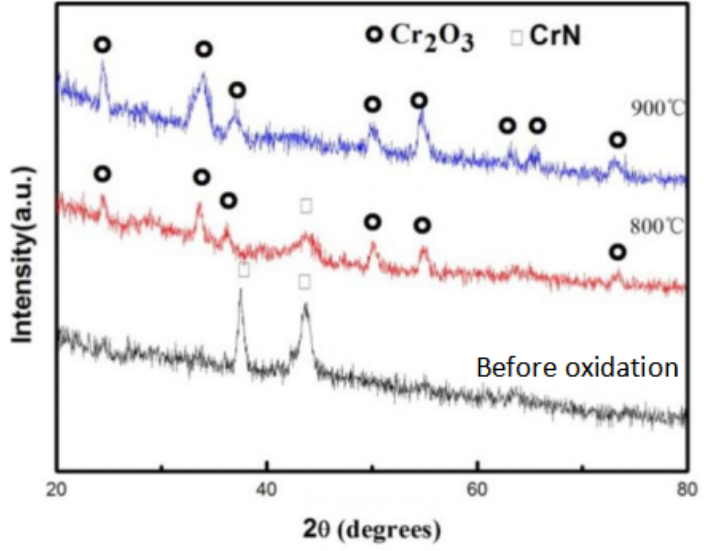
Figure 9. XRD patterns of CrSiN coatings before and after oxidation.